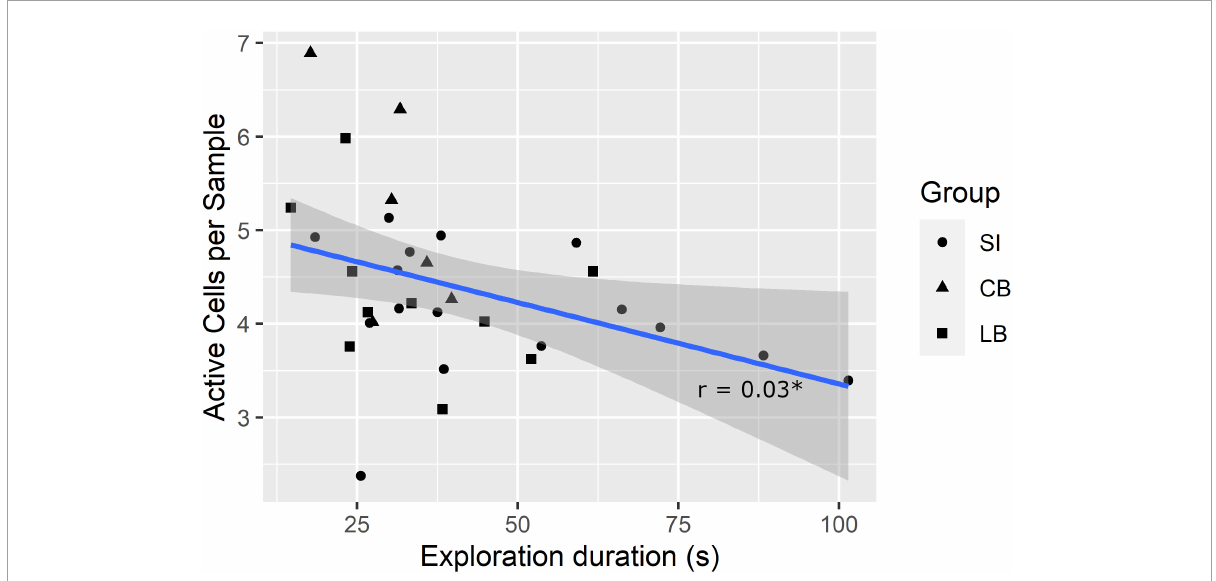
FIGURE4 Correlation between exploration duration and mean number of active cells per sample. *p fdr < 0.05.